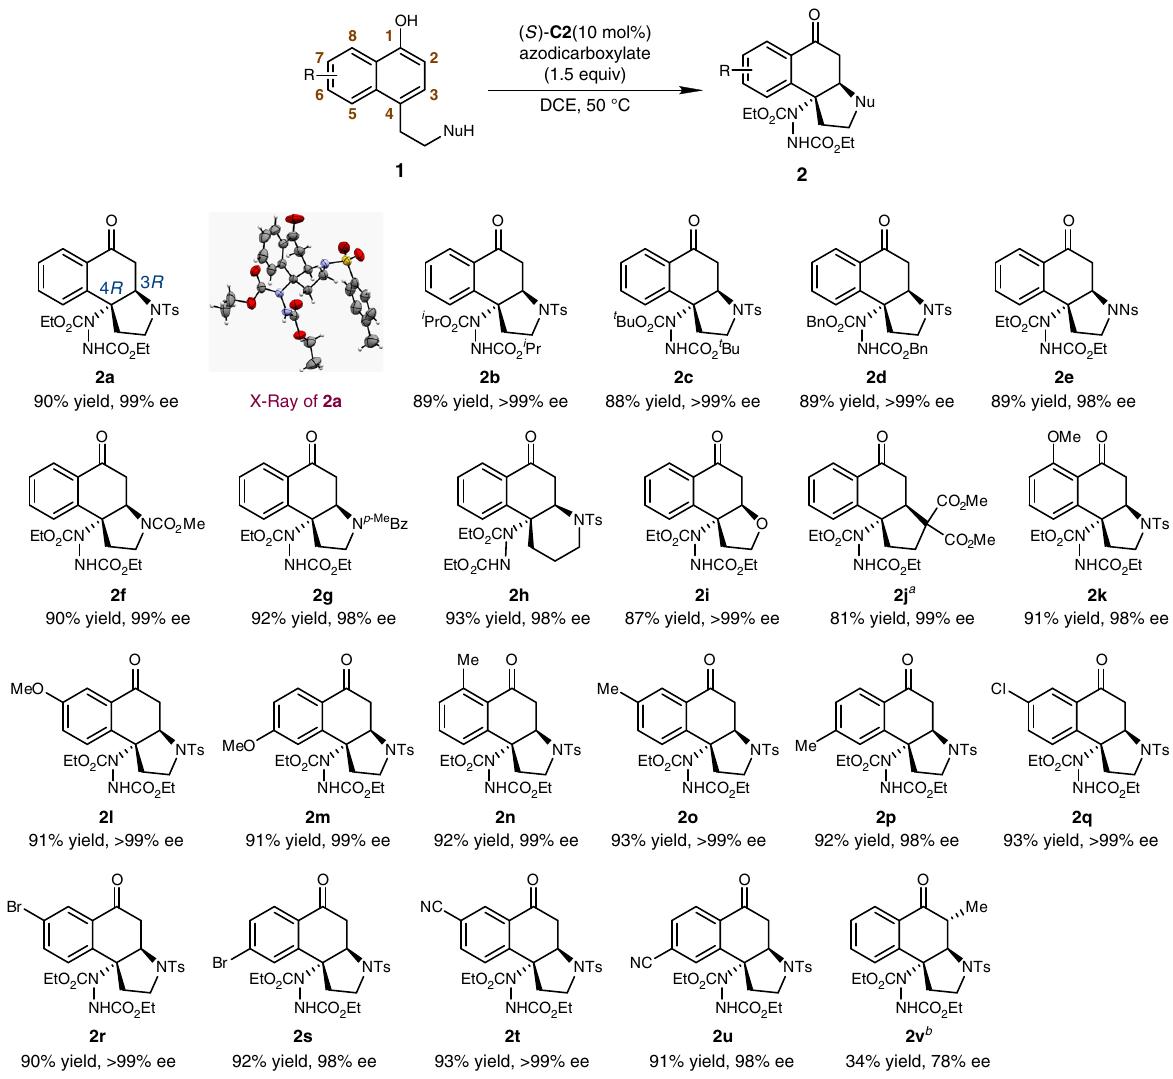
Fig. 2 Substrate Scope of α -Naphthols. Reaction conditions: 1 (0.1 mmol), azodicarboxylate (0.15 mmol) and ( S )- C2 (10 mol%) in DCE (2 mL) at 50 °C. a After work up, t BuOK (2 equiv in THF) was added at rt. b At 0.2 mmol scale. Bz, benzoyl